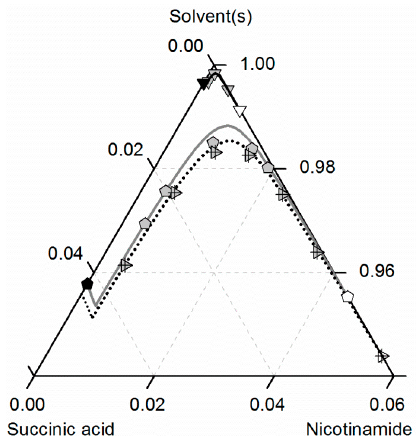
Figure 8. Solubilities of nicotinamide (NA) and succinic acid (SA) and the corresponding 2:1 cocrystal (CC) in ethanol (pentagons, gray solid lines), acetonitrile (triangle pointing downwards, black solid lines) and an ethanol/acetonitrile mixture 0.67/0.33 w / w (crossed triangle pointing to the right, black dotted lines) at 298.15 K with shortened axes in mole fractions. Lines correspond to the PC-SAFT predictions; symbols refer to the experimental data points of SA (black), the CC (gray) and NA (white).